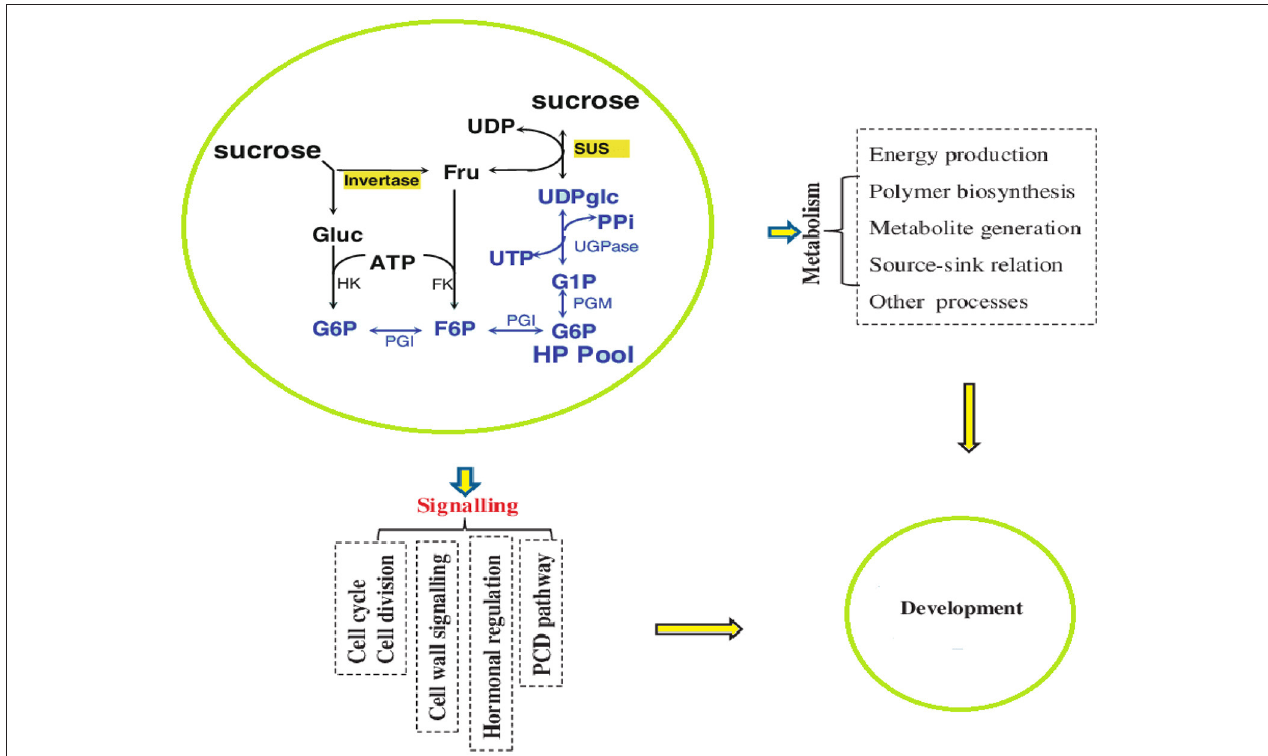
FIGURE 3 | Summary of sugar biosynthesis and